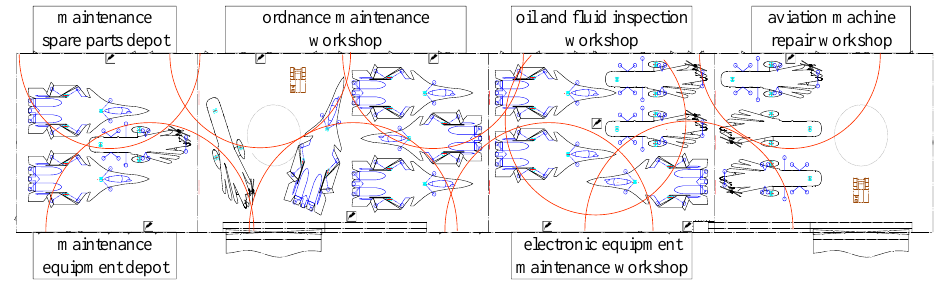
Figure 2. Maintenance resources and environment of the Kuznetsov aircraft carrier hangar bay.